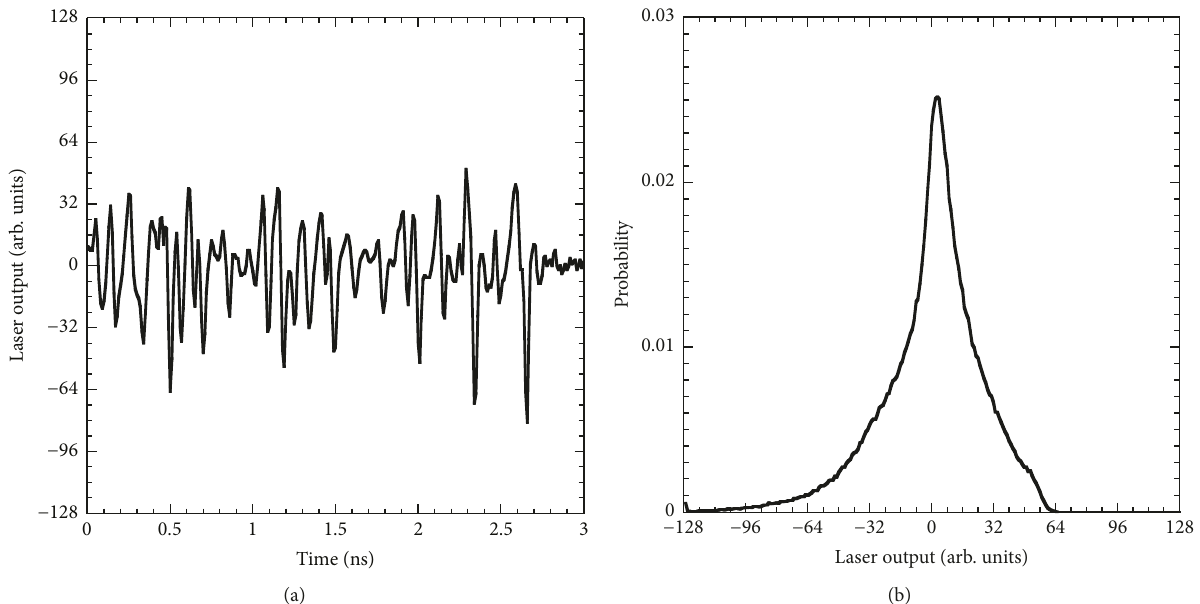
Figure 3: (a) Temporal waveform of the laser output and (b) the corresponding histogram of the amplitude of the temporal waveform.